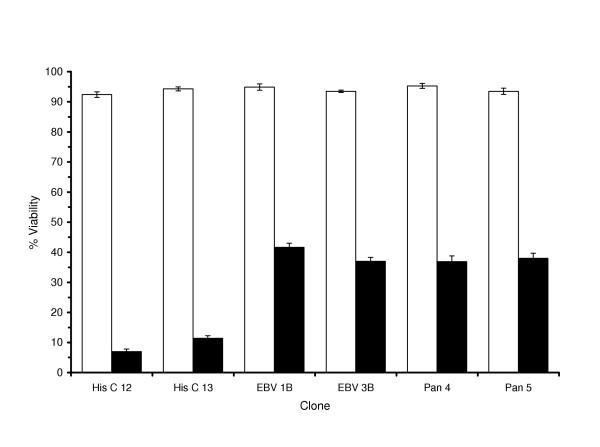
Determination of apoptosis levels in UV irradiated cells. The effect of 30 Jm-2 UV irradiation (solid bars) on EBV BHRF1 and H. pan BHRF1 transfected Ramos-BL clones compared to vector controls. Cell viability was assayed after 24 hours by acridine orange fluorescence. The data plotted are the means three experiments carried out in triplicate ± standard error. Statistical analysis was performed using ANOVA and Tukey's pairwise comparison on data normalised by arcsine transformation